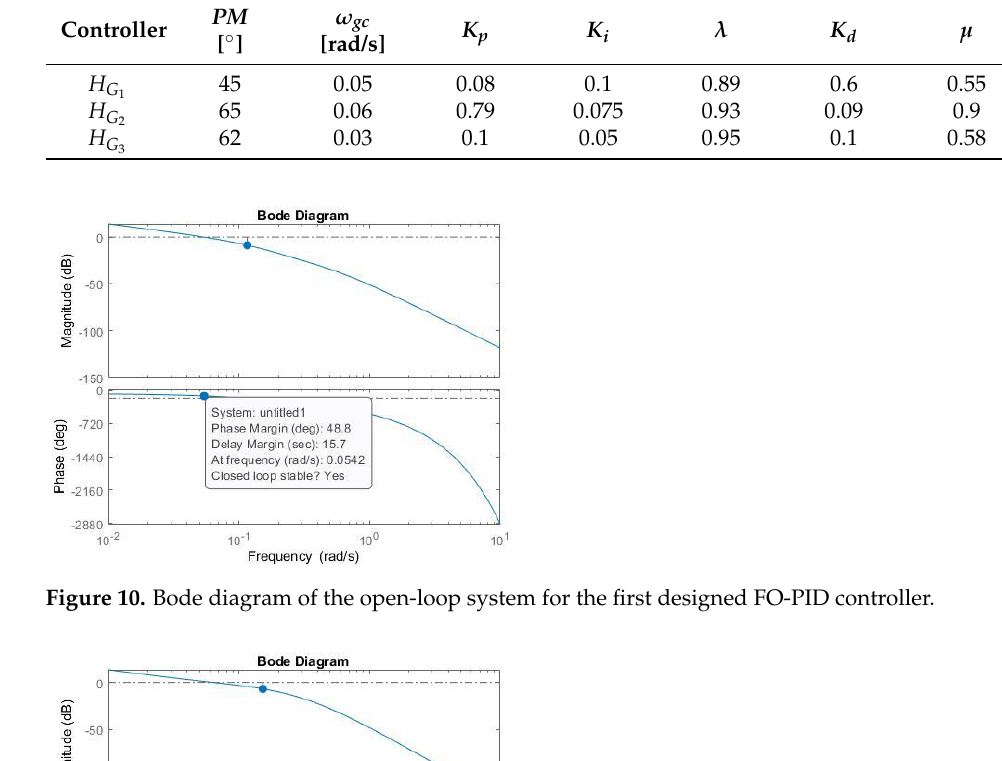
Figure 12. Bode diagram of the open-loop system for the third designed FO-PID controller.